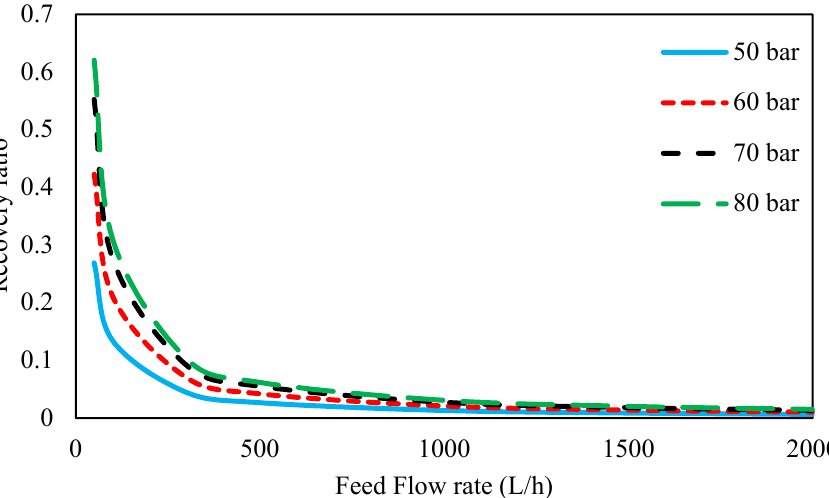
Figure 14. Recovery ratio for 45 wt. % MDEA solution at different inlet feed pressures and feed flow rates.